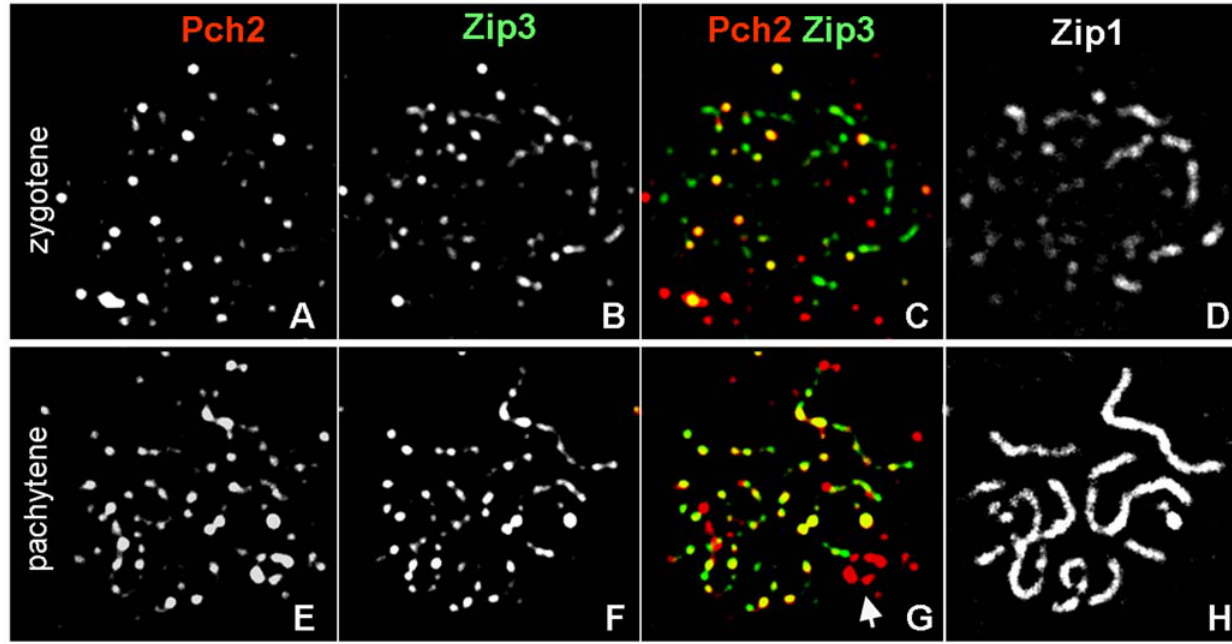
Figure 2. Association of Pch2 with CO designation marker Zip3 at different stages of synapsis. (A–D) Spread nucleus during early zygonema from a strain carrying HA-Pch2 and Zip3-GFP, stained with antibodies against HA- and GFP-epitopes as well as Zip1. (E–H) Spread pachytene nucleus. Arrow indicates rDNA cluster (G). Colors are indicated by the corresponding labels. Meiosis was induced at 33 u C.